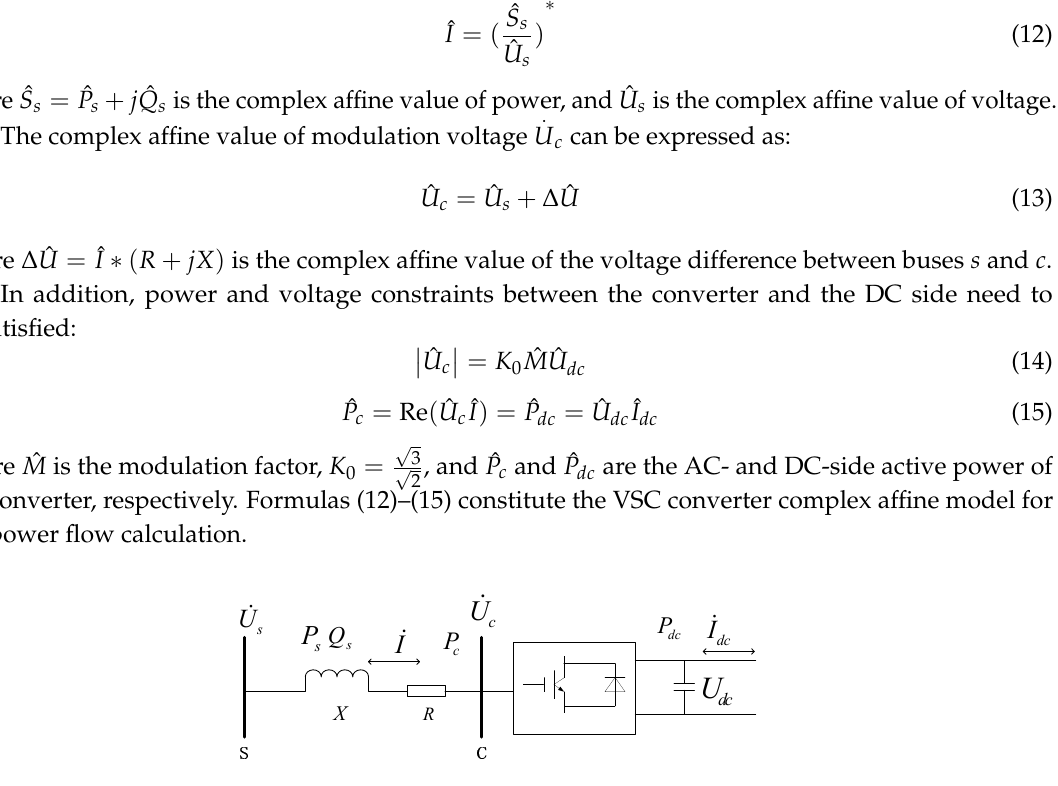
Figure 3. Model of a VSC station.